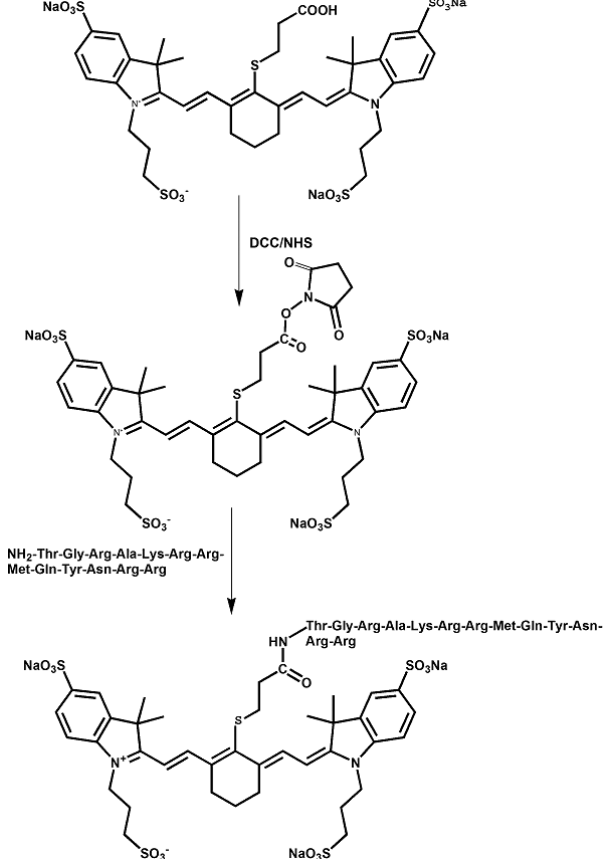
Fig. 1. Synthesis of